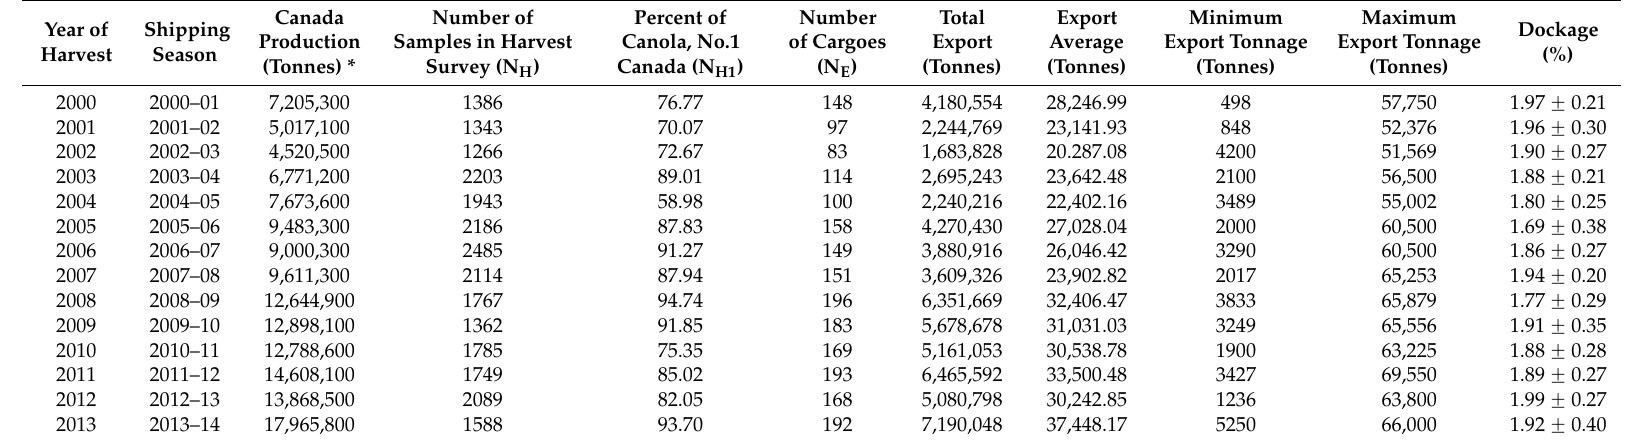
Table 1. Summary table—Canadian canola production, number of samples received in the harvest survey with the percent of samples graded Canada No. 1 Canola, number of export cargoes analyzed by the monitoring program and the tonnage they represent (average, minimum and maximum), and percent dockage average of the export cargoes from 1 August 2000 to 31 July